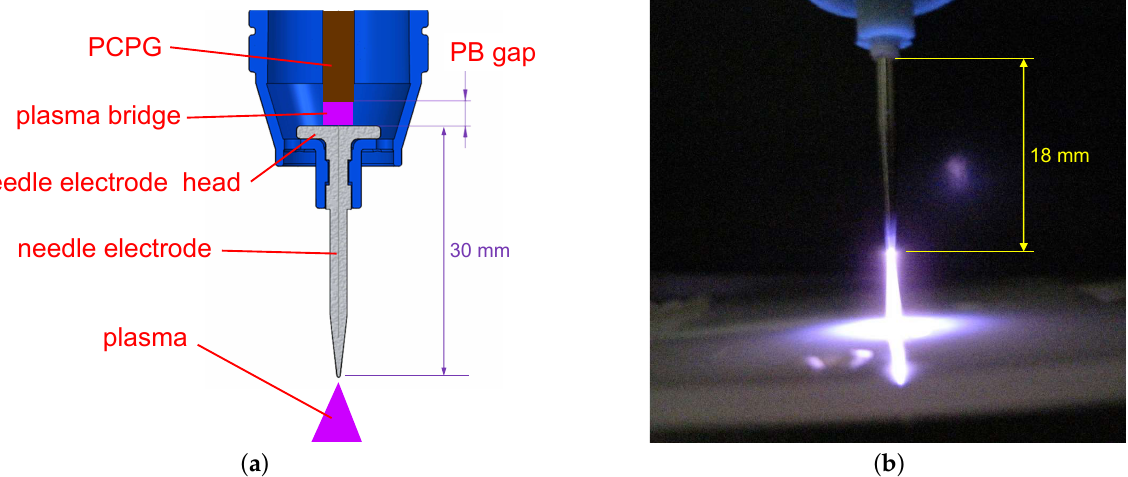
Figure 18. The piezobrush ® PZ3 needle nozzle. ( a ) discharge architecture; ( b ) spark discharge between the needle and the aluminum